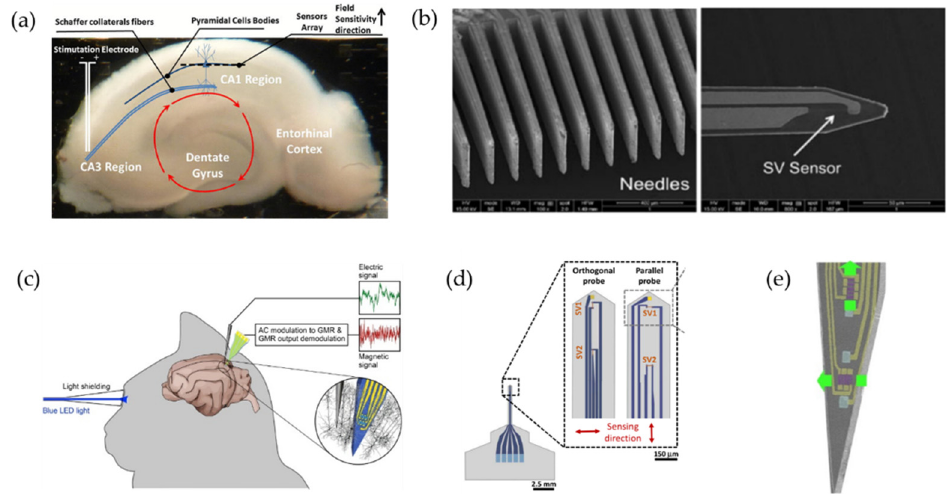
Figure 7. ( a ) Hippocampus slice with the relative position of the sensor array with respect to the hippocampus structure. Red arrows represent the hippocampal network forming a well-characterized closed loop due to synaptic and action potential sources [155]. Reprinted with permission from AIP Publishing 2011. ( b ) SEM image of the needles array and the tip of the needle with a well-defined SV sensor [157]. ( c ) Schematic representation of the in vivo experimental set-up to record neural responses from rat cerebral cortex [22]. Reprinted with permission from Elsevier 2017. ( d ) Schematic view of the sharp magnetrodes with orthogonal and parallel configurations and the position of SV1, SV2, and gold electrode along the probe. The arrows indicate the sensing direction [159]. ( e ) Photograph of the GMR magnetrode with orthogonally sensitive directions. Reprinted with permission from [161]. Copyright 2020 American Chemical Society.